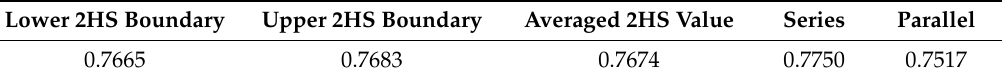
Table 15. Two-phase thermal conductivity approximations—cement system F.